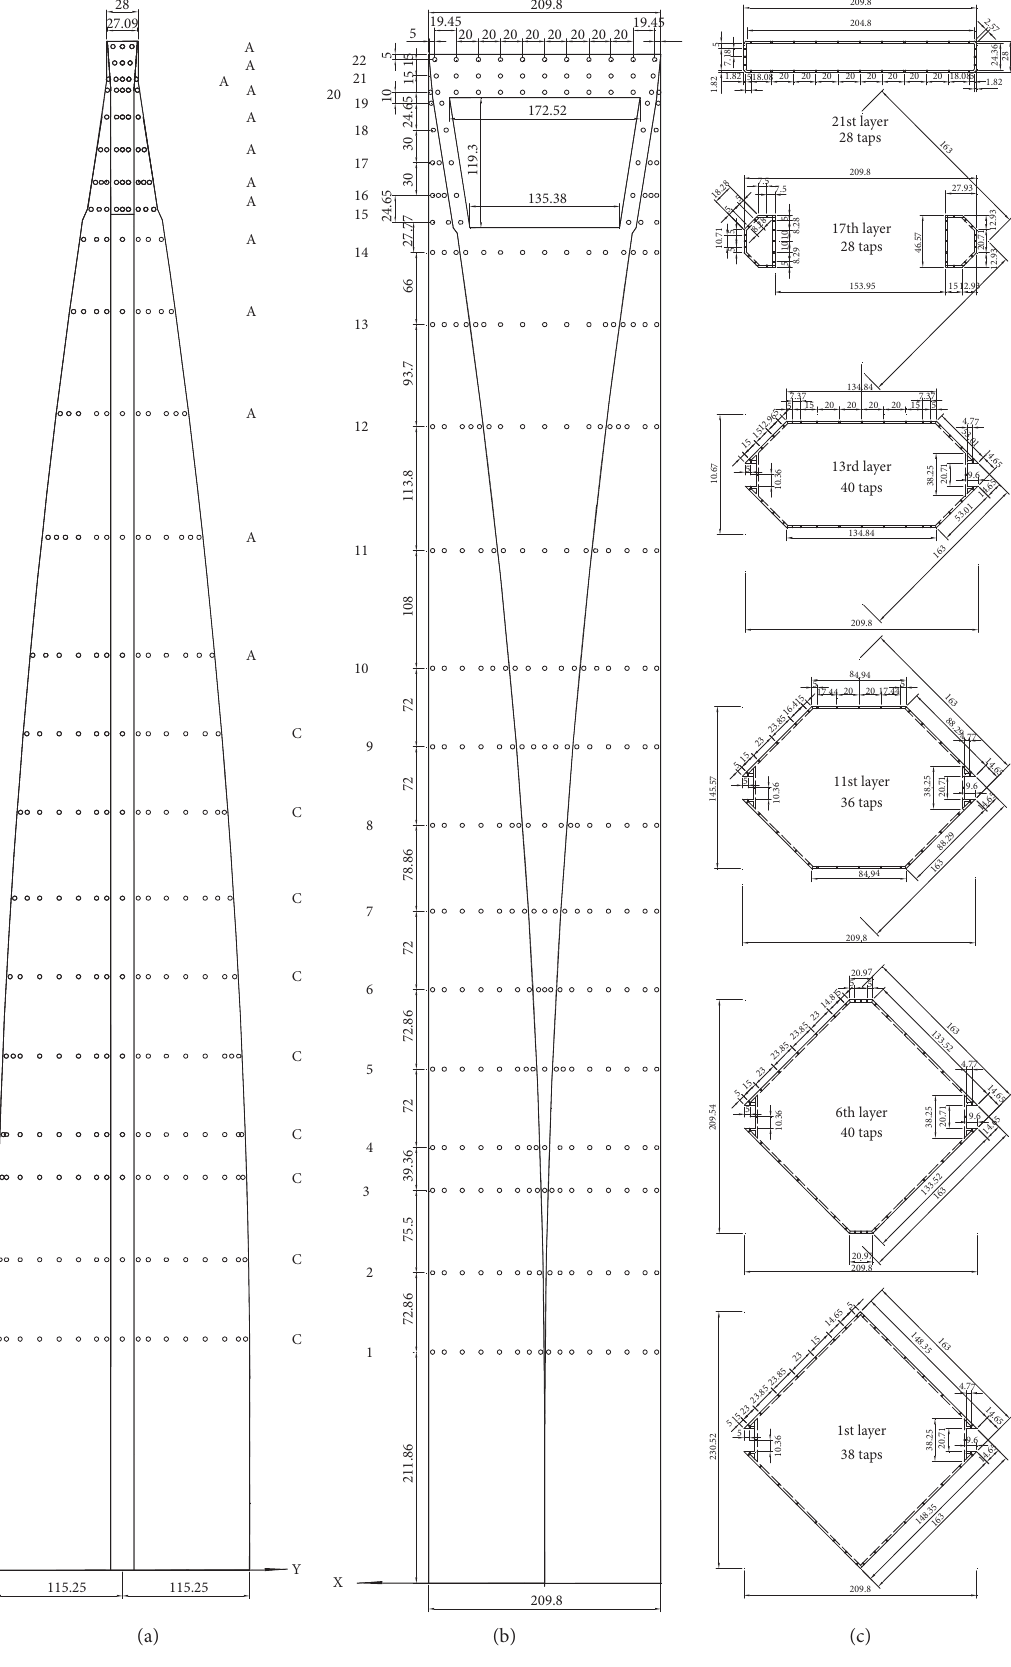
Figure 7: The shape and measuring tap arrangement of façade and cross-sections of typical heights. (a) Side elevation. (b) Front elevation. (c) Cross section on typical